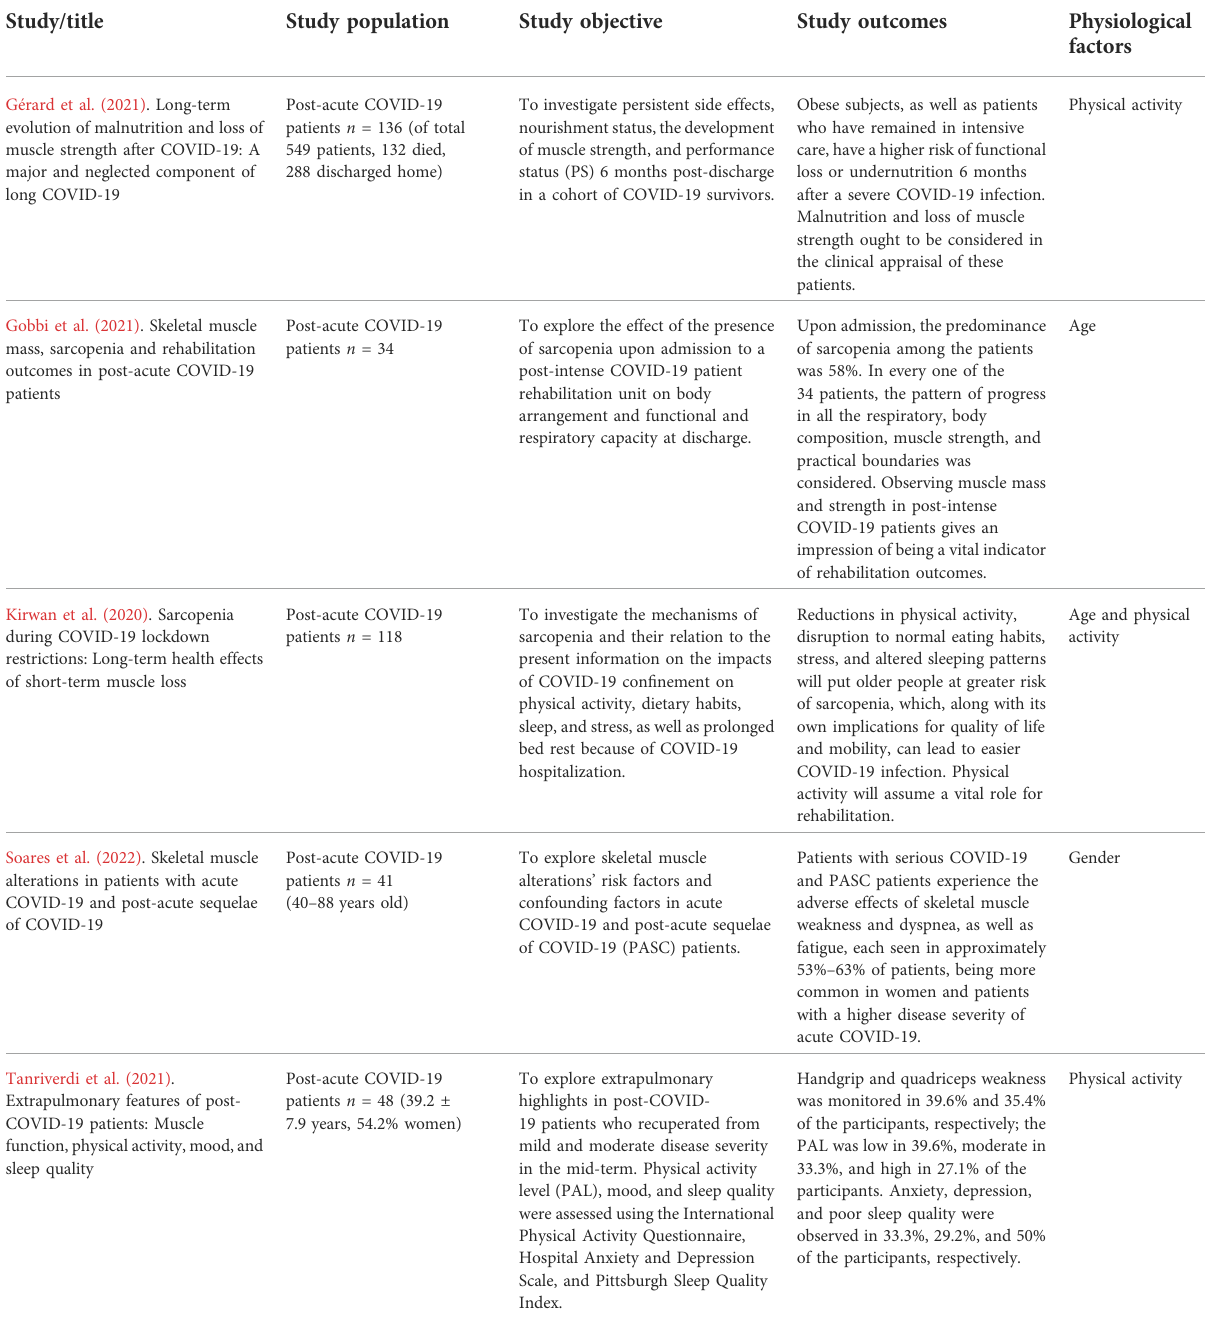
TABLE 1 Summary of selected post-COVID-19